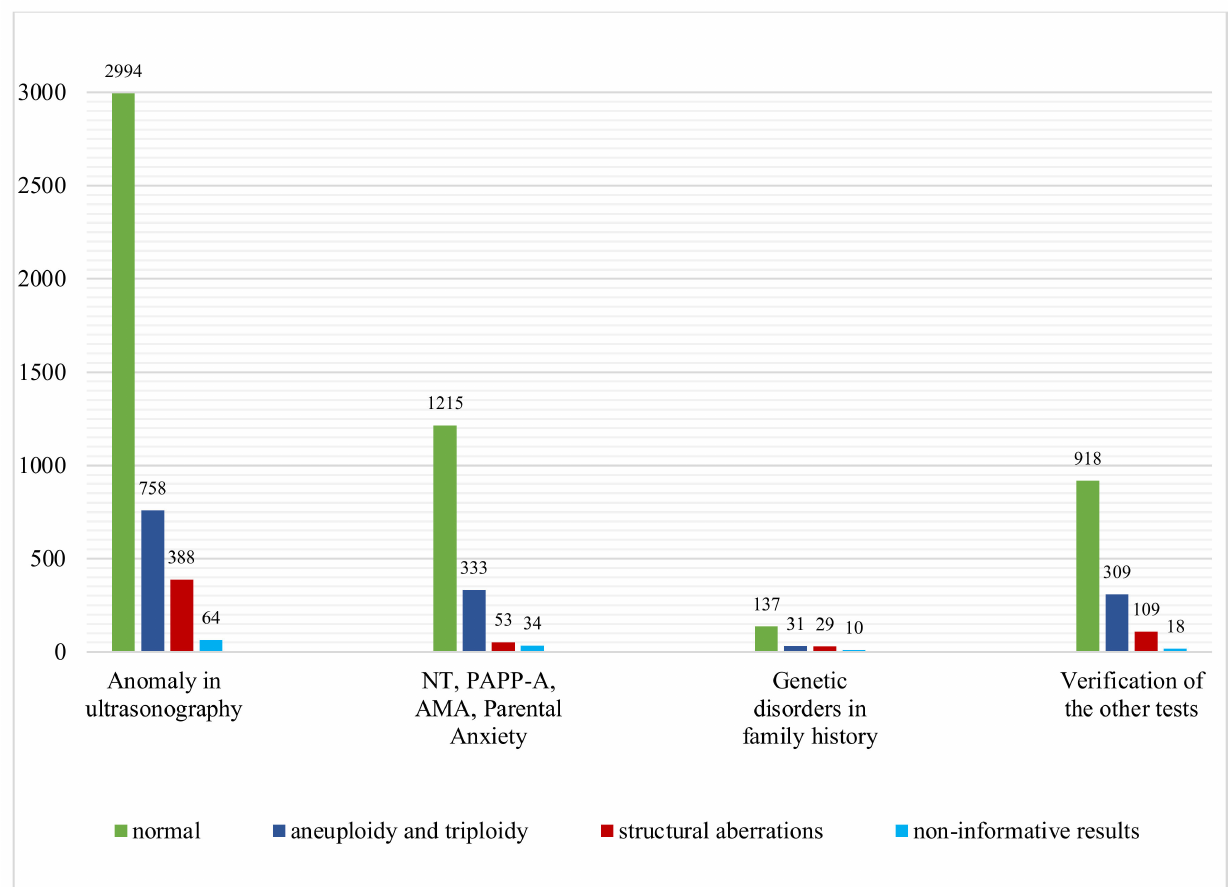
Figure 2. Microarray CGH results of 7400 samples: number of cases with normal results, aneuploidy and triploidy and structural aberrations in four subgroups of different indications for prenatal